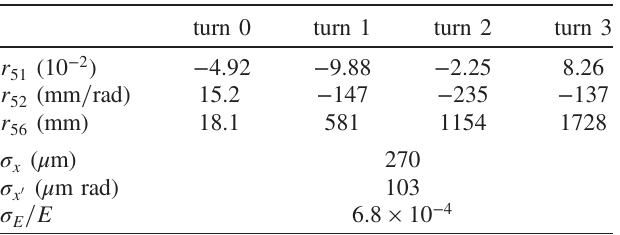
TABLE I. Parameters for the calculation of the turn-0 to turn-3 gain curves for DELTA (see text for details).